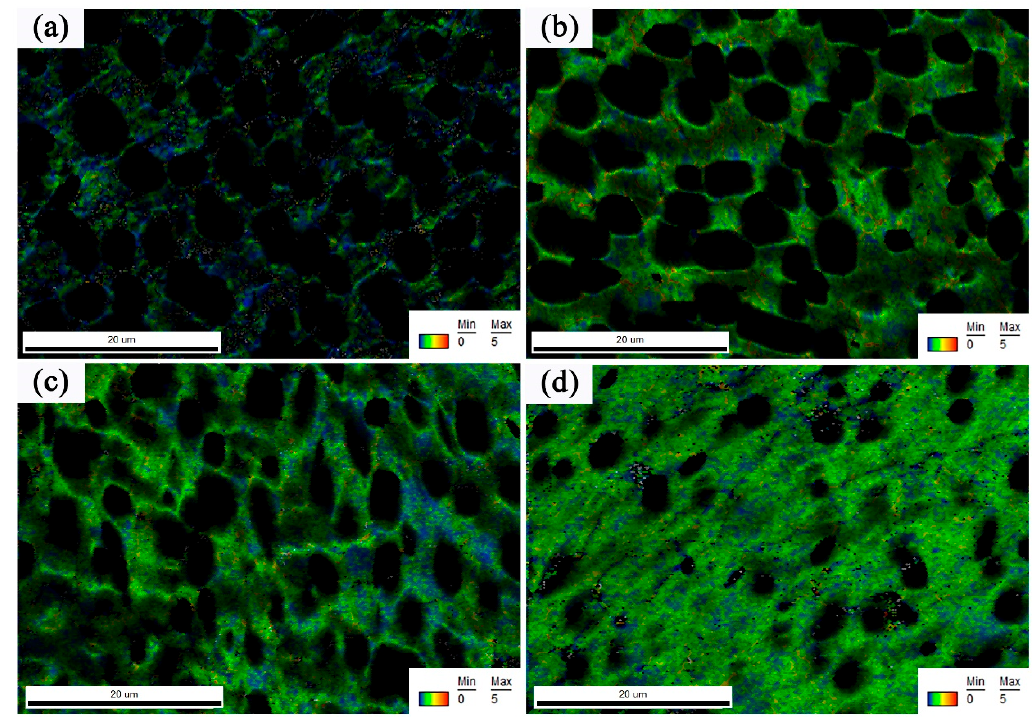
Figure 6. Kernel average misorientation (KAM) figures of samples after first-pass compression at ( a ) 700 °C, ( b ) 750 °C, ( c ) 800 °C, ( d ) 850 °C.